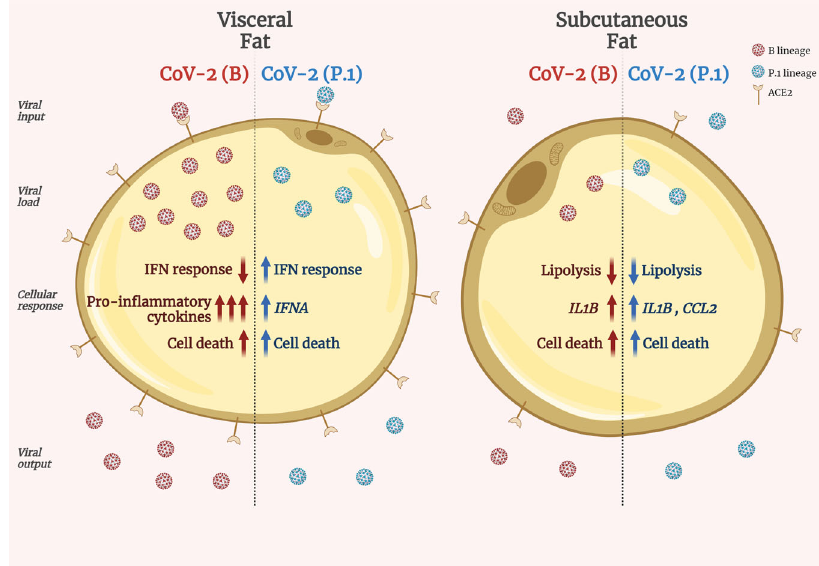
Fig. 6 | SARS-CoV-2 infects adipose tissue in a fat depot- and viral lineage- dependent manner. CoV-2(B), original B SARS-CoV-2 lineage. CoV-2(P.1), SARS- CoV-2 gamma variant P.1. IFN interferon, IFNA interferon alpha gene, IL1B